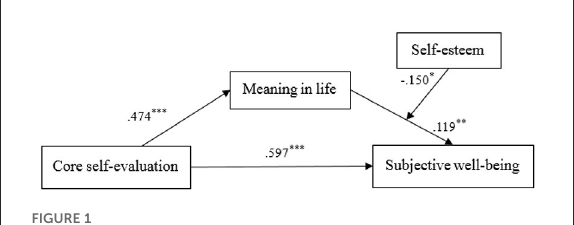
FIGURE1 Path coefficients of the moderated mediation model. * Indicates significant paths: * p < 0.05, ** p < 0.01, *** p < 0.001.